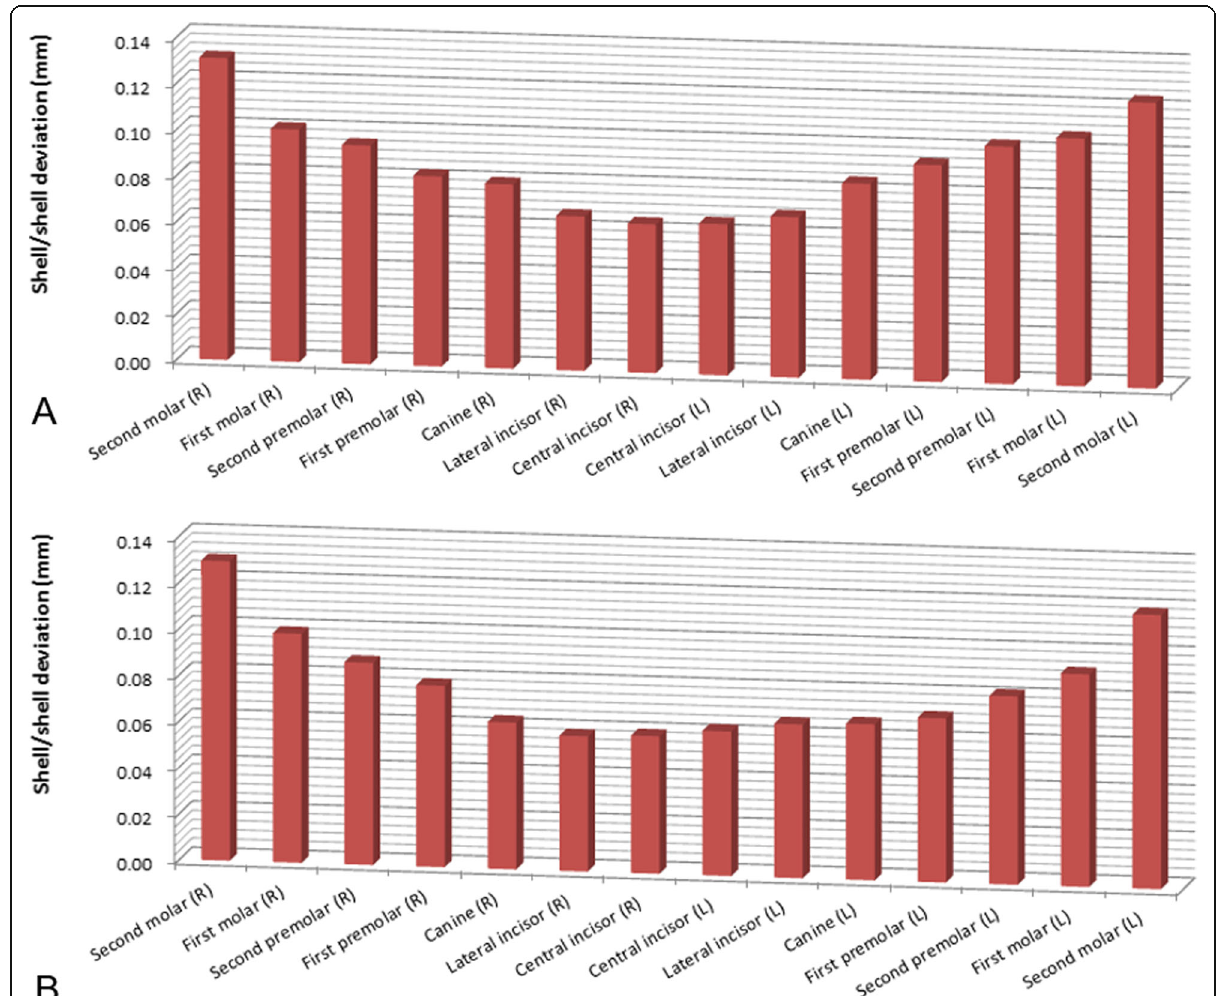
Fig. 3 Graphic presentation of shell/shell deviation of individual tooth in complete-arch scan. a Maxilla. b